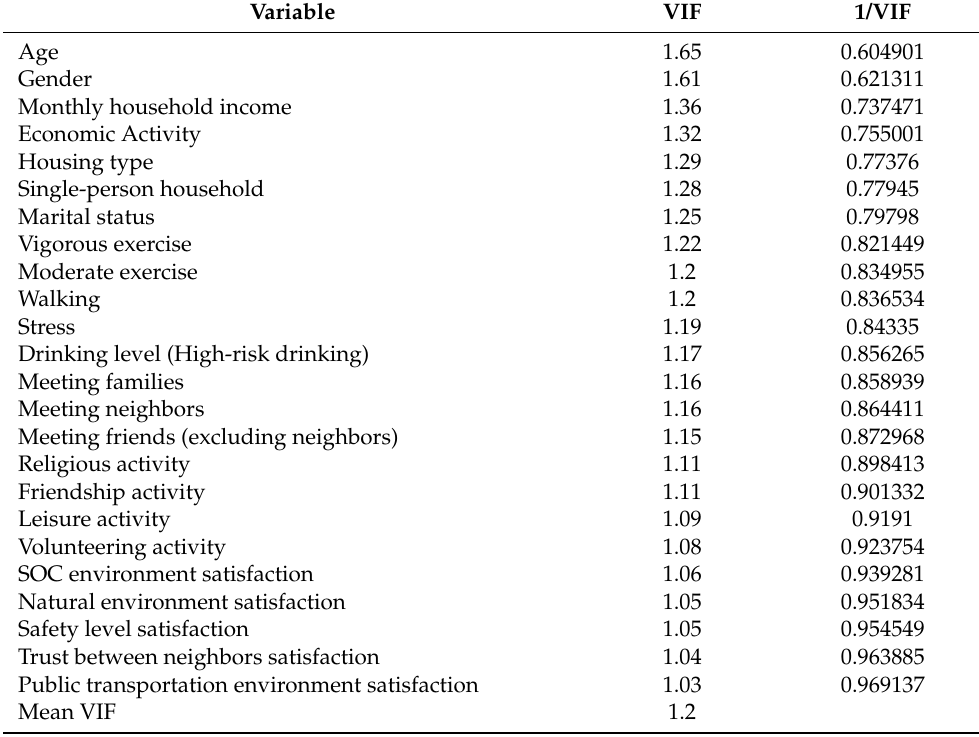
Table 3. Variance Inflation Factor (VIF) between independent variables.